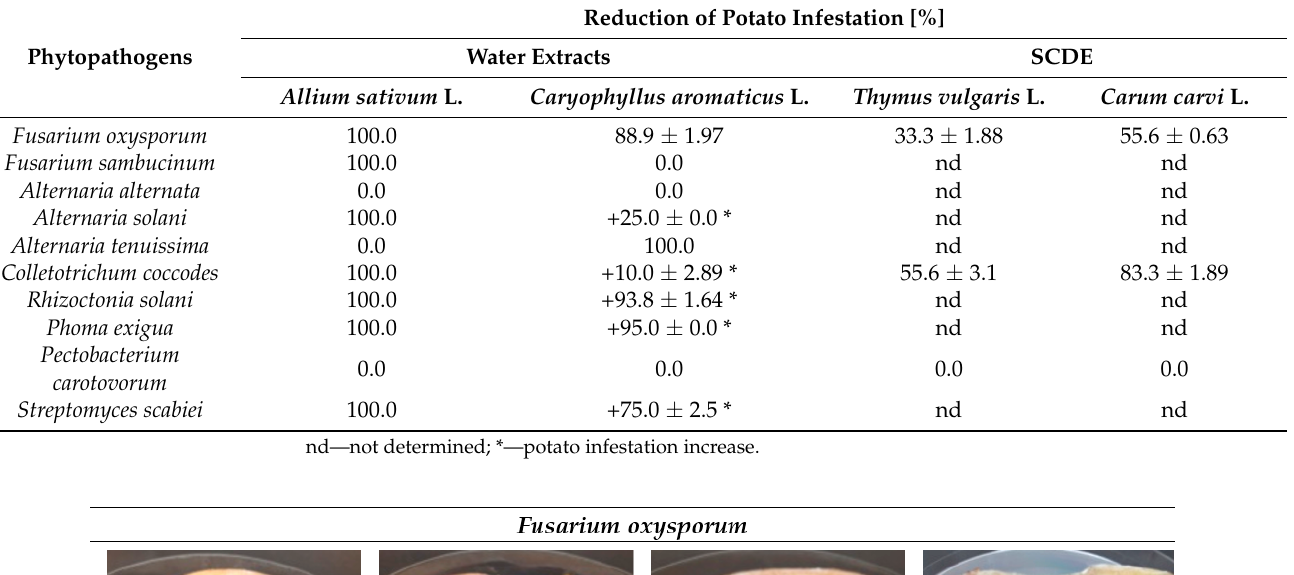
Table 6. Reduction of potato seed cv. Impresja infestation treated with selected plant extracts against potato phytopathogens.